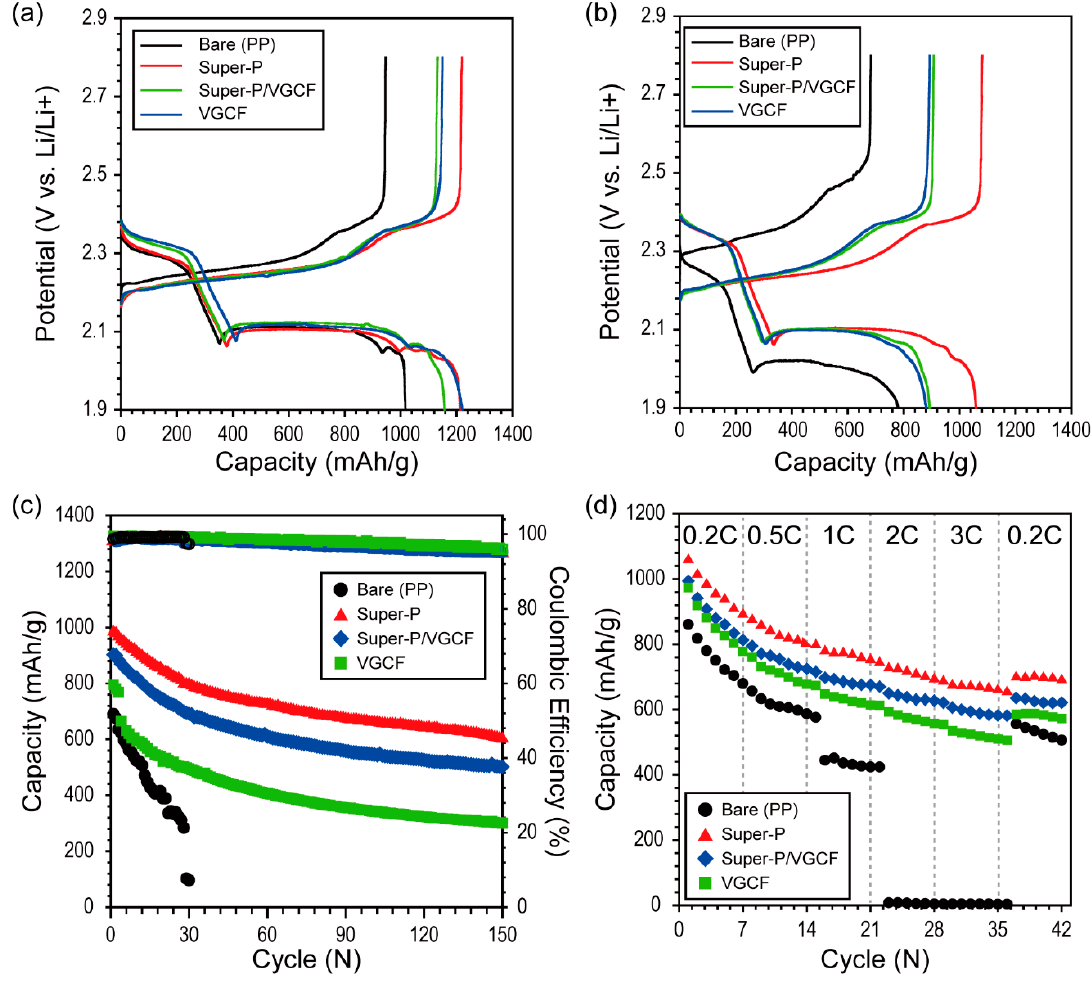
Figure 3. Charge/discharge potential profiles during ( a ) pre-cycling (current density = C/5) and ( b ) the first cycling for rate capability test (associated with Figure 3d); ( c ) cycle performance for the Li–S batteries containing various carbon-coated separators, respectively (current density = 1 C); and ( d ) rate cyclability (charging current density was varied from C/5 to 3 C, while the discharging current density was fixed at C/5). Super-P/VGCF consisted of Super-P:VGCF = 5:5 by wt.%.